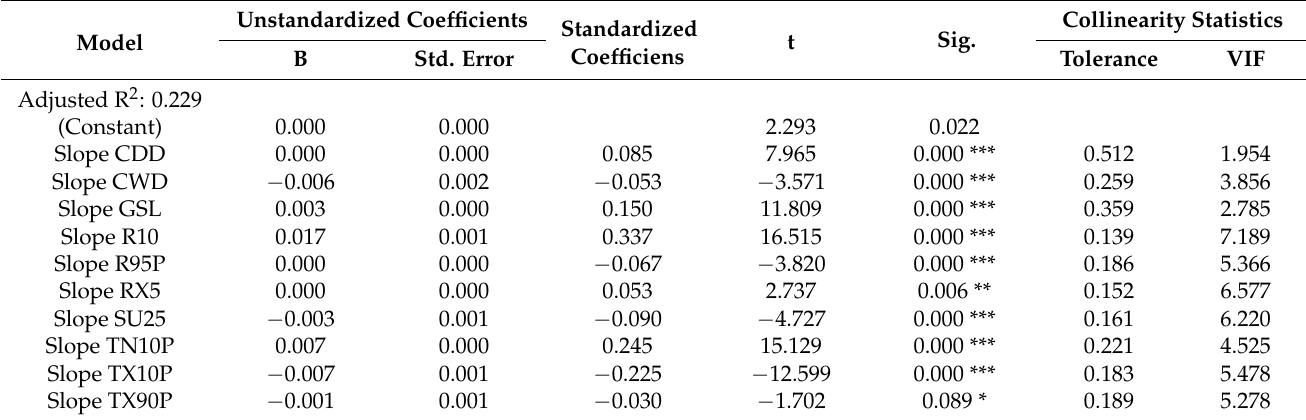
Table 3. Model of the impact of extreme climate on the normalized difference vegetation index (NDVI) of typical steppe.